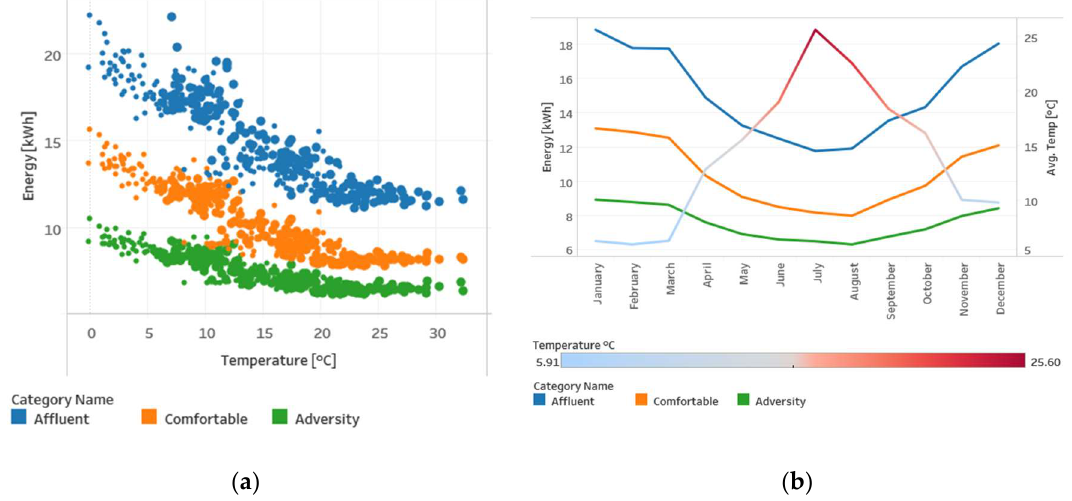
Figure 9. Energy consumption versus temperature: ( a ) scatter plot and ( b ) time-line plot.